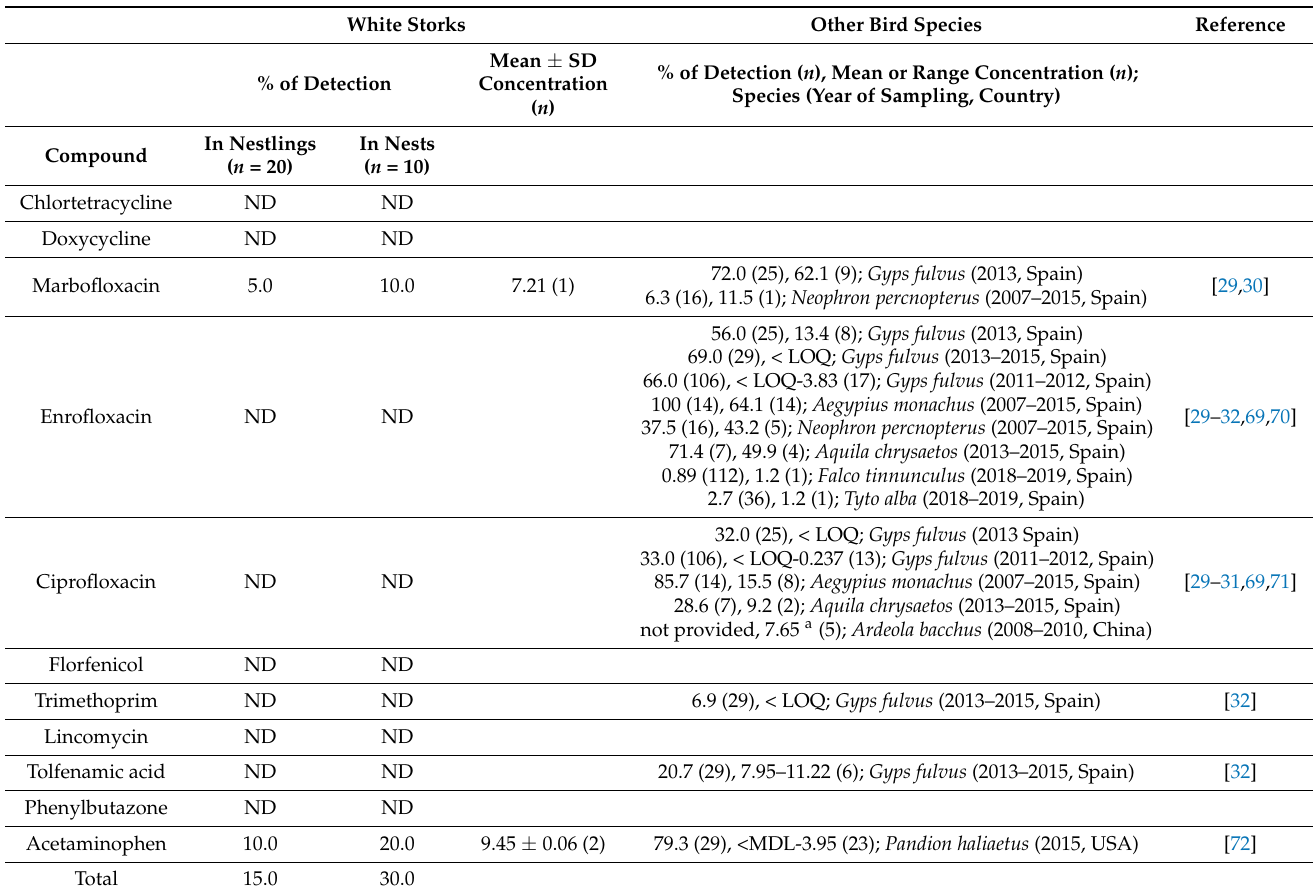
Table 2. Cont. White Storks Other Bird Species